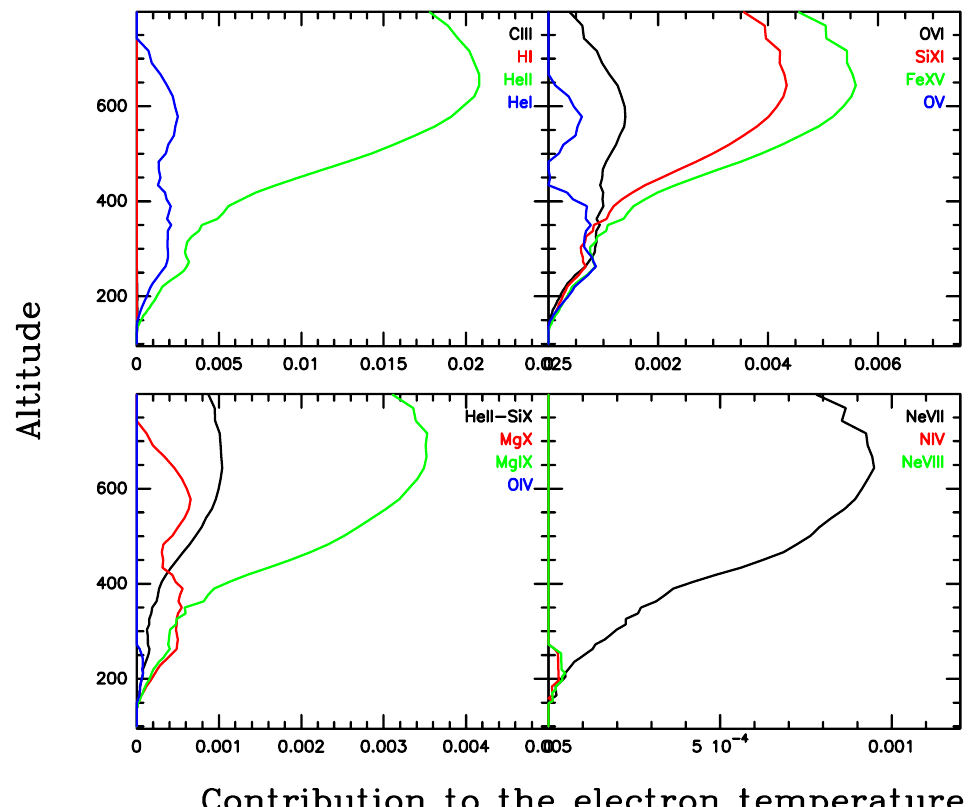
Fig. 7. Relative contribution of the different XUV/EUV lines to the electron temperature. The scales of the abscissa varies from one plot to the